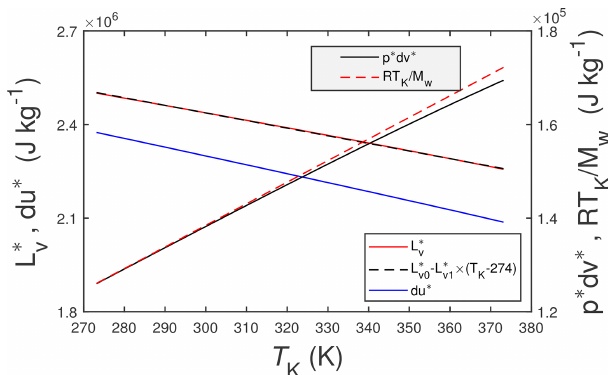
Figure 1. The solid red line is the enthalpy of vaporization of pure water, L ∗ v , from Wagner and Pruß (2002), and the dashed black line = 3 . 16924 × 10 6 Jkg − 1 is a linear approximation to it, where L ∗ v 0 = 2 . 4405 × 10 3 Jkg − 1 K − 1 . The solid blue line is the ther- and L ∗ v1 modynamic change in internal energy, d u ∗ , associated with L ∗ v . The other two lines are p ∗ (cid:49)v ∗ (solid black) and RT K /M w (dashed red). Here T K is the temperature in K, R (Jmol − 1 K − 1 ) is the universal gas constant, and M w = 0 . 0180153kgmol − 1 is the molecular mass of water